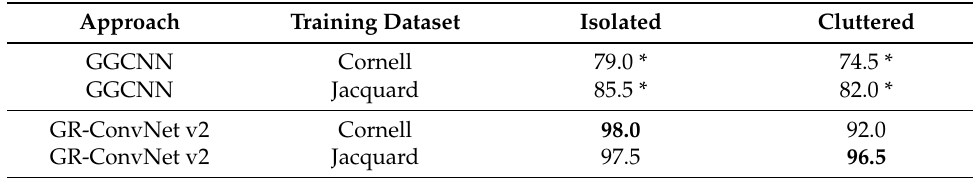
Table 7. Pick success rate (%) on YCB objects in simulation.